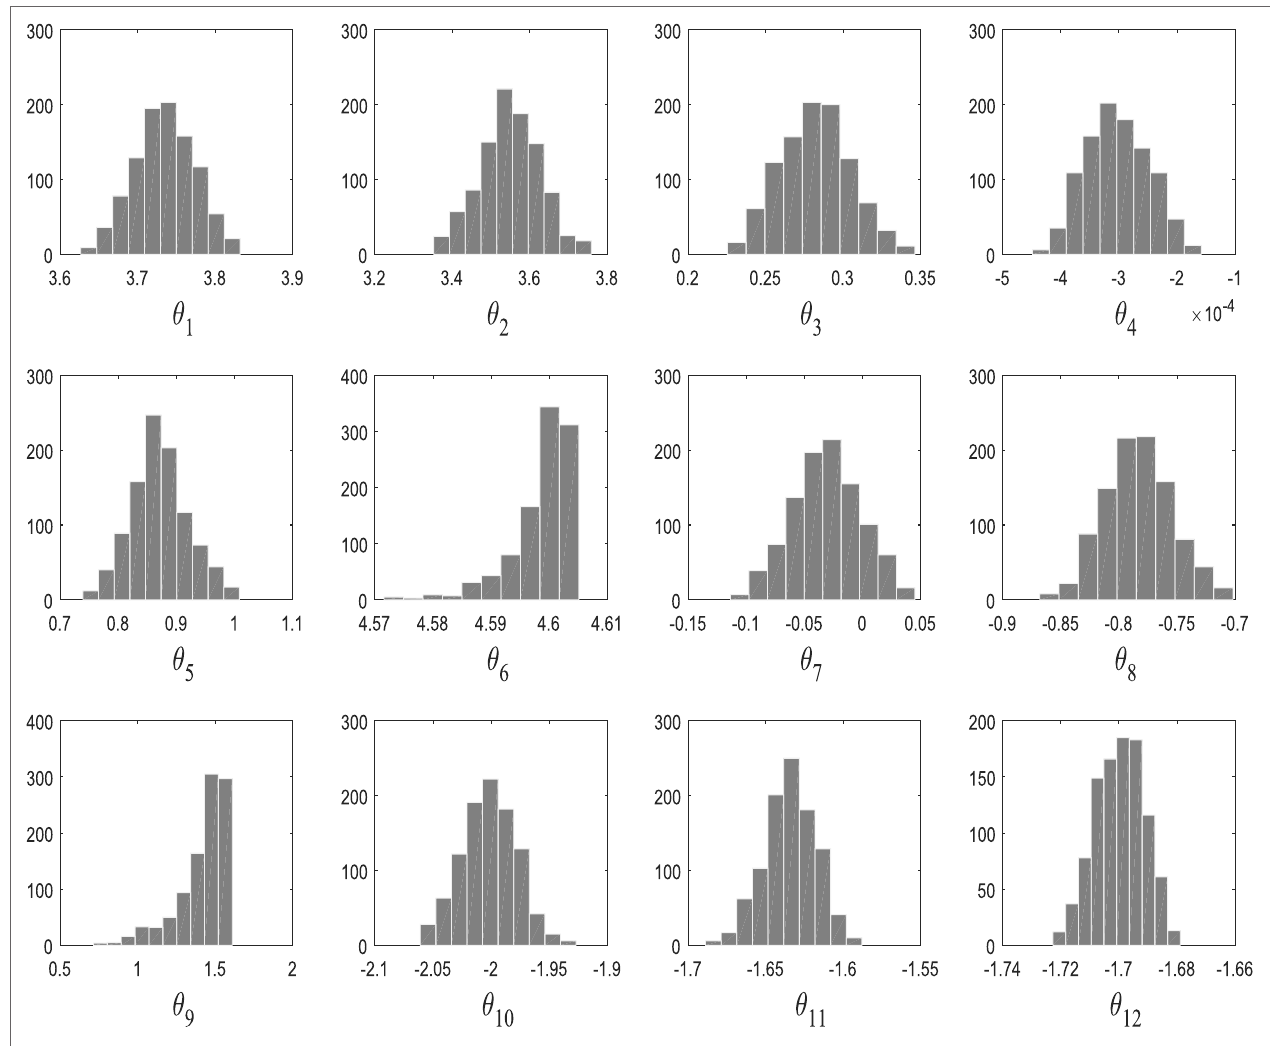
FIGURE 9 | Histograms of the selected model parameters M 1 .